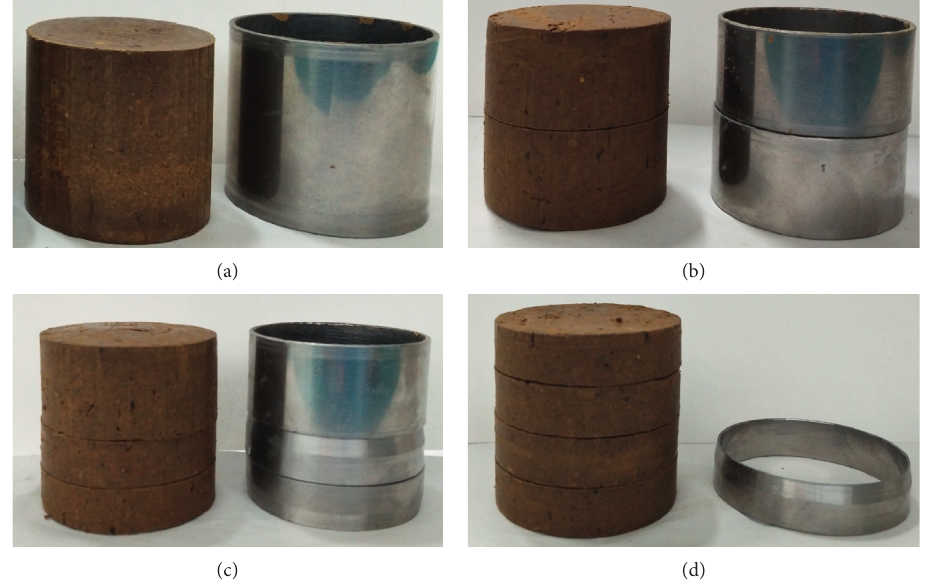
Figure 2: Frozen silty soil specimens for dynamic tests with various prefabricated crack